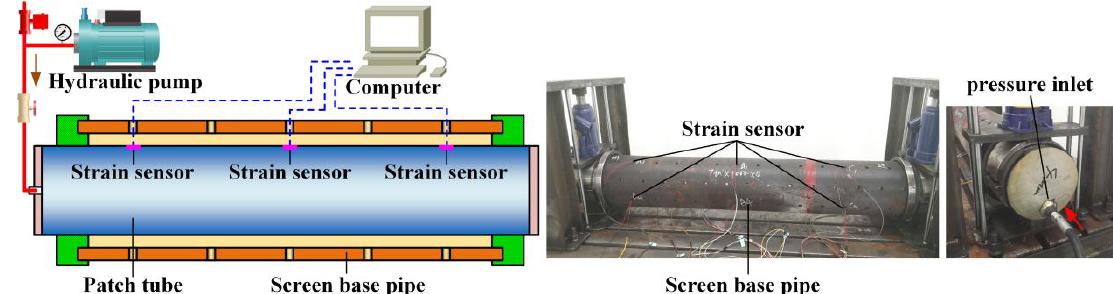
Figure 13. Hydroforming test of patch tube.